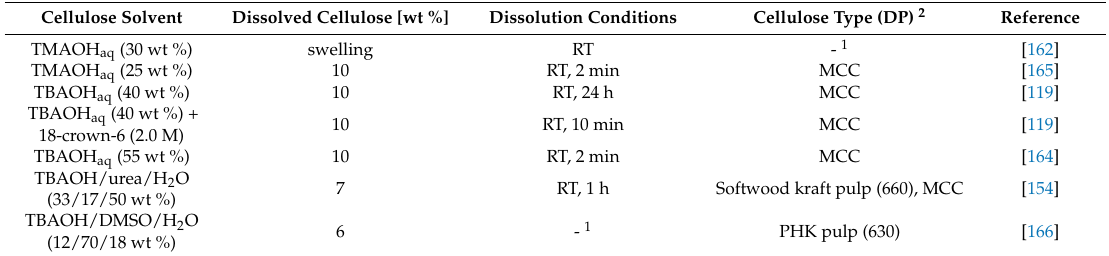
Table 1. Examples of the solubility of cellulose in tetra-( n -alkyl)ammonium hydroxide aqueous solutions. Cellulose Solvent Dissolved Cellulose [wt %] Dissolution Conditions Cellulose Type (DP) 2 TMAOH aq (30 wt